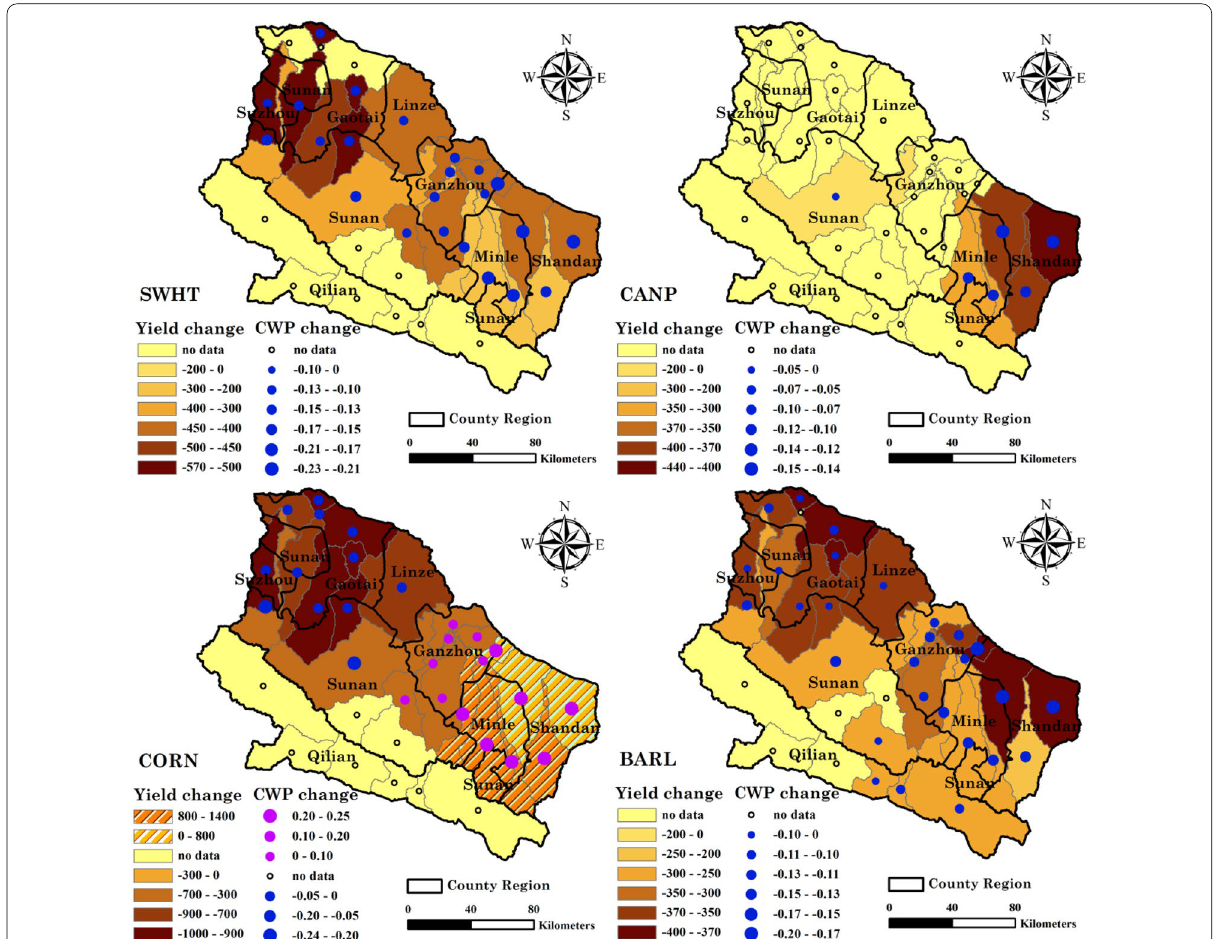
Fig. 7 The change of short-term crop yields and CWP of wheat (SWHT), canola (CANP), corn (CORN), and barley (BARL) relative to the historical baseline period in the climate scenario